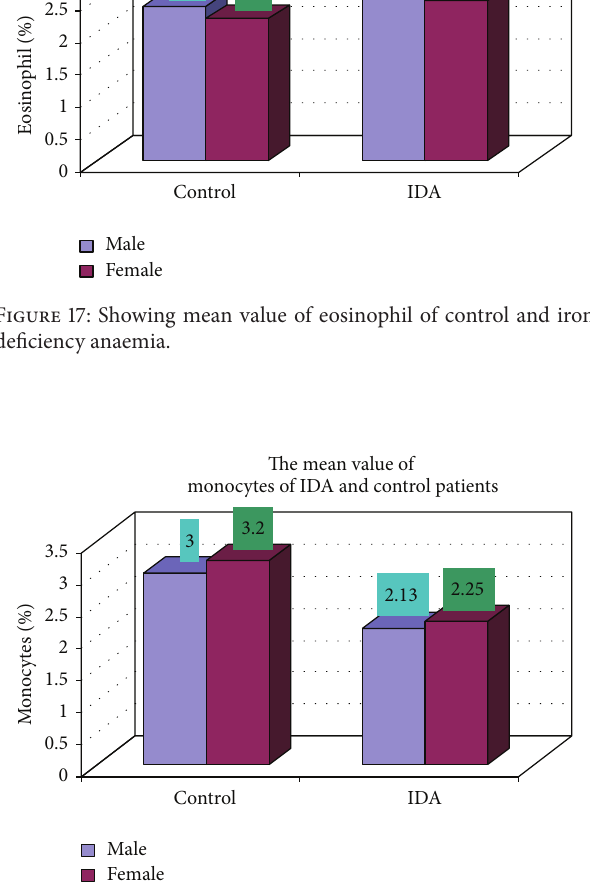
Figure18:Showingthemeanvalueofmonocytesofcontrolandiron deficiency anaemia.